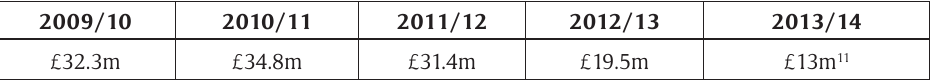
Table 5: English Heritage grants budget